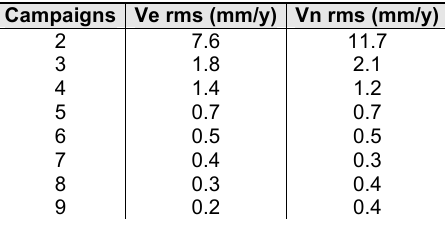
Table 2. East and north velocity error thresholds, defined from the subsampling procedure. The velocity thresholds for the relevant campaign numbers are given.